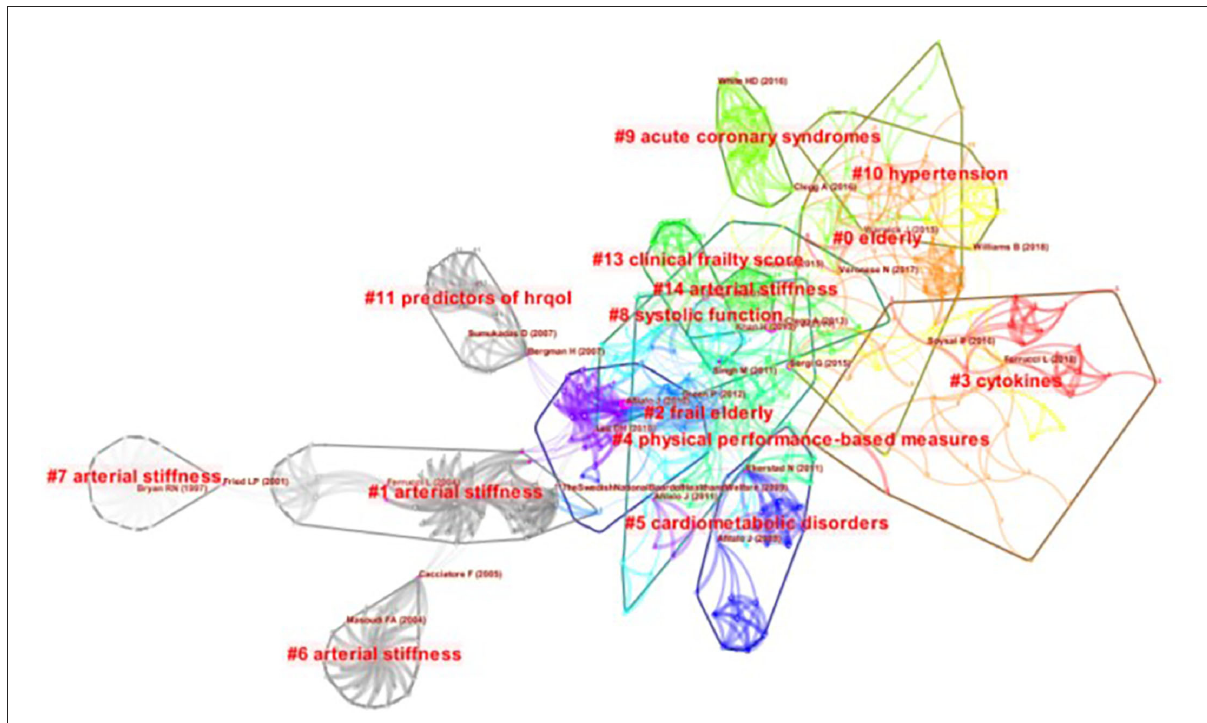
FIGURE5 Clusters of cited references related to CVD with frailty from 2000 to 2021.